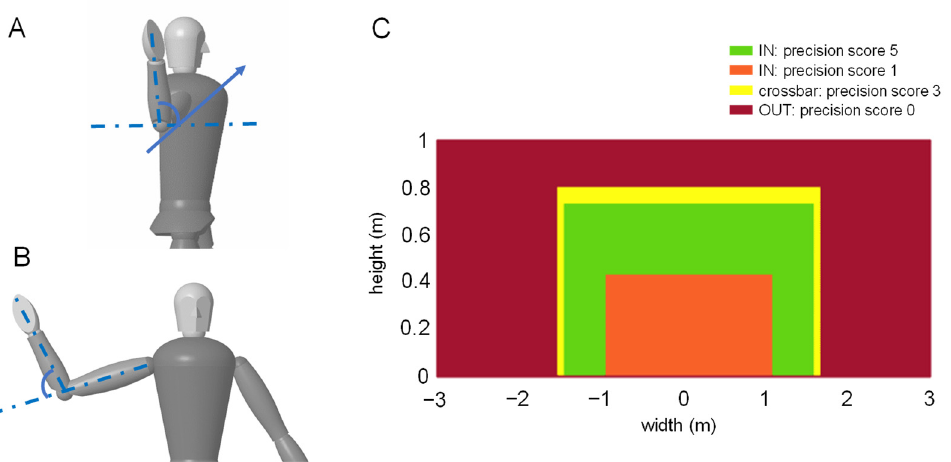
Figure 3. Definition of shoulder angle ( A ) and elbow angle; ( B ) definition of the different throwing areas for the automatic assignment of precision score; ( C ) green area → precision score 5; orange area → precision score 1; yellow area → precision score 1; and red area → precision score